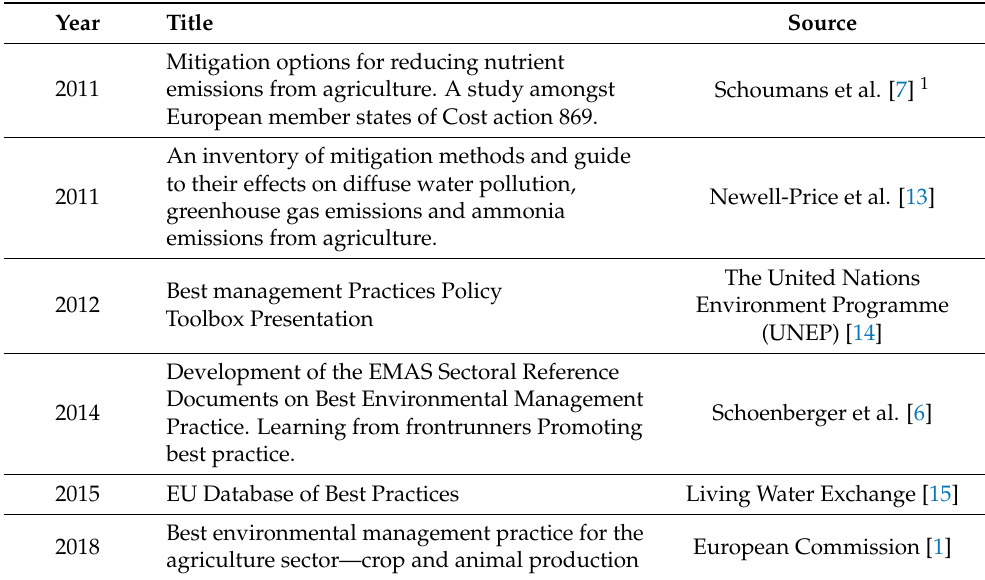
Table 1. Guidelines and reports describing GAPs for agricultural P and N pollution mitigation and control. Modified from Drizo